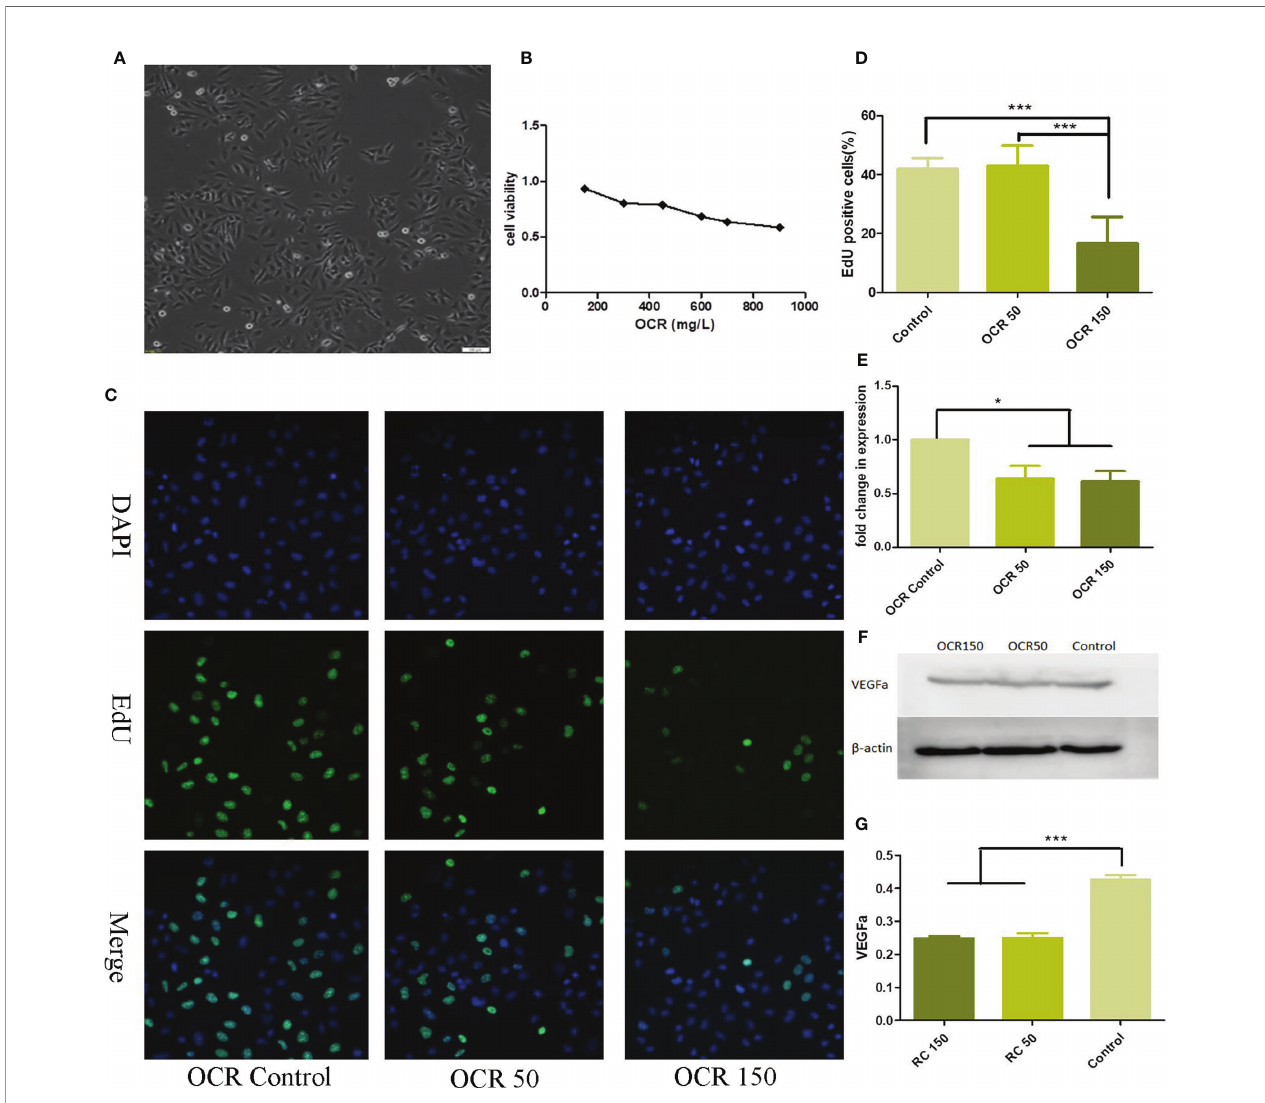
FIGURE 3 | The effects of essential oil from Curcumae rhizoma (CR) (OCR) on HUVECs. (A) HUVEC morphology. (B) The effects of different OCR concentrations on HUVEC viability. (C, D) The effects of OCR on HUVEC proliferation. (E) The effects of OCR on VEGFa mRNA expression in HUVECs. (F, G) The effects of OCR on VEGFa protein expression in HUVECs. (n = 3, mean ± standard deviation (SD), ***P < 0.001, *P < 0.05 compared with the control